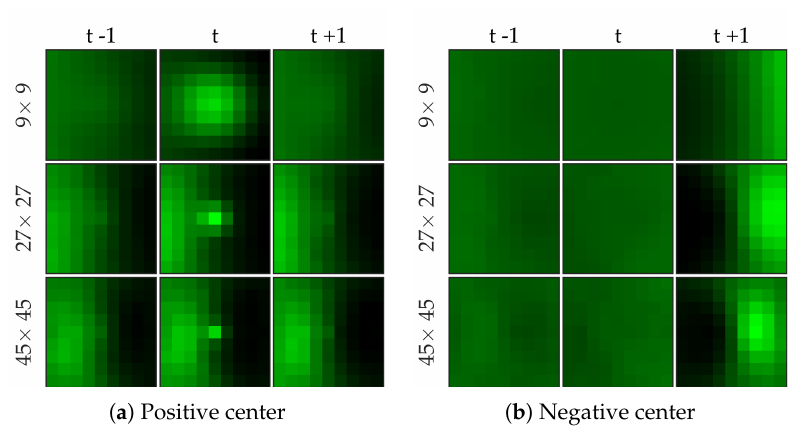
Figure 7. Examples of centers of RBF network for bacteria dataset.